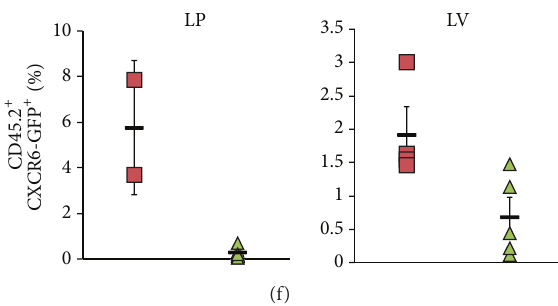
Figure 3: CXCR6 contributes to fetal ILC3 and ILC3 precursor circulation. (a) Flow cytometry of lineage depleted (Lin: CD3 𝜀 , CD11c, CD19, Ter119, Gr1, NK1.1) E15.5 fetal liver (FL). ILC3 precursors are defined as Lin − IL-7R 𝛼 + c-Kit med ROR 𝛾 t + . (b) Percentages of Lin − IL- 7R 𝛼 + c-Kit med (left panel) and absolute numbers (right panel) of FL ILC3 precursors as defined in Figure 2(a) in FL from Cxcr6 +/+ (wt, blue losange), Cxcr6 Gfp/+ (HZ, red square) or Cxcr6 Gfp/Gfp (KO, green triangle) E15.5 embryos. (c) Flow cytometry of Lin − compartment fetal spleen (FS) from Cxcr6 Gfp/+ E15.5 embryos. Lin − CD 4 hi IL-7R 𝛼 + cells (red) and total Lin − cells (filled gray) are analyzed for CXCR6-GFP (left histogram) and ROR 𝛾 t (right histogram). (d) Scheme depicting injection and reconstitution experiment. (e) Analysis of reconstitution experiment. 1000 to 2000 Ly5.2 Lin − CD 4 hi IL-7R 𝛼 + CXCR6 + cells were injected in nonlethally irradiated Rag2 − / − 𝛾 c − / − Ly5.1 mice. Recipients were killed 4 weeks after injection and intestinal lamina propria (LP, upper panels) and liver (LV, lower panels) were analyzed by flow cytometry.(f)PercentagesofreconstitutionexperimentasexplainedinFigures2(d)and2(e)using Cxcr6 Gfp/ + (HZ,redsquares)or Cxcr6 Gfp/Gfp (KO) E15.5 embryos in intestinal LP (left panel) or LV (right panel). Results are representative of at least 3 experiments each ((a), (c): 𝑛 > 5 ), or are from 3 pooled experiments ((b), wt: 𝑛 = 6 , HZ: 𝑛 = 10 , KO: 𝑛 = 4 ), or are from at least 2 pooled experiments ((e), (f), LP HZ: 𝑛 = 2 , LP KO: 𝑛 = 5 , LV HZ: 𝑛 = 4 , LV KO: 𝑛 = 5 ). In ((b), (f)), each dot represents a single mouse. Statistical data are displayed with mean and